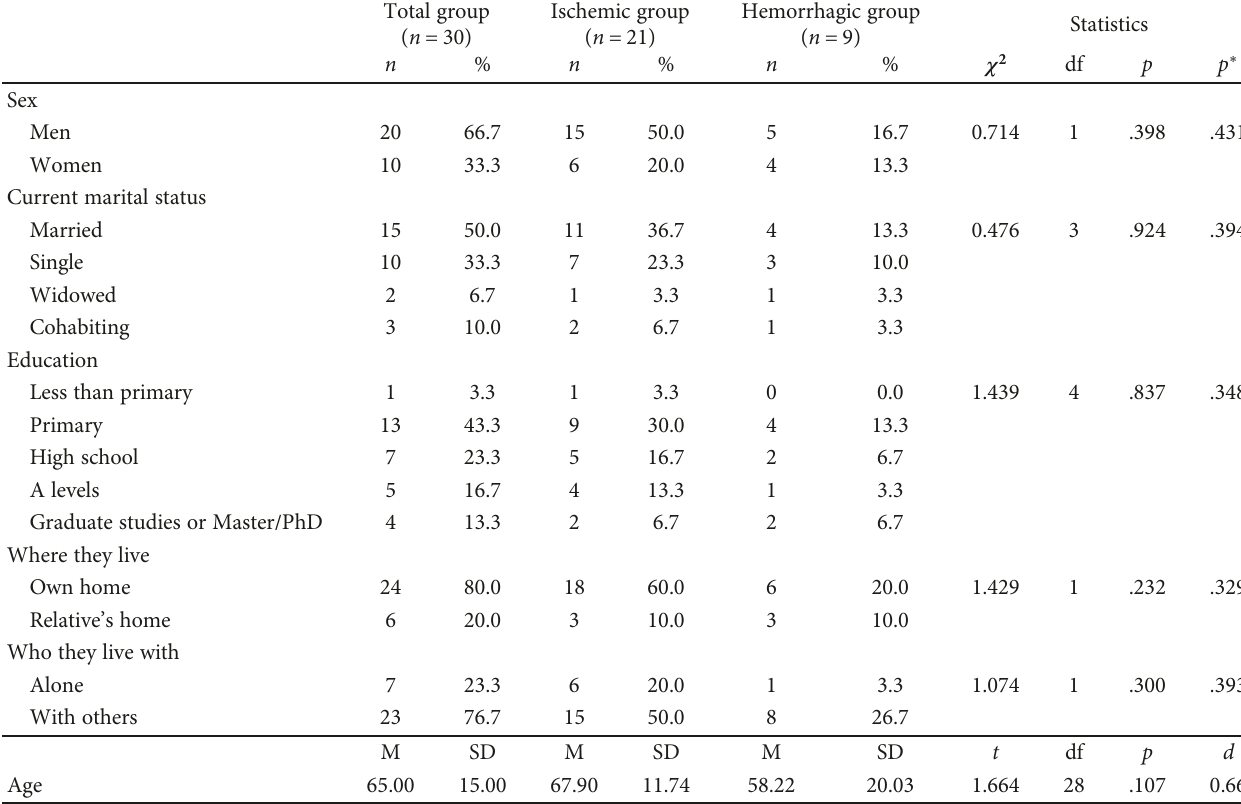
Table 1: Sociodemographic characteristics of the